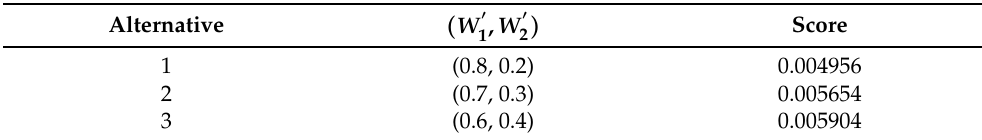
Table 8. Score of each